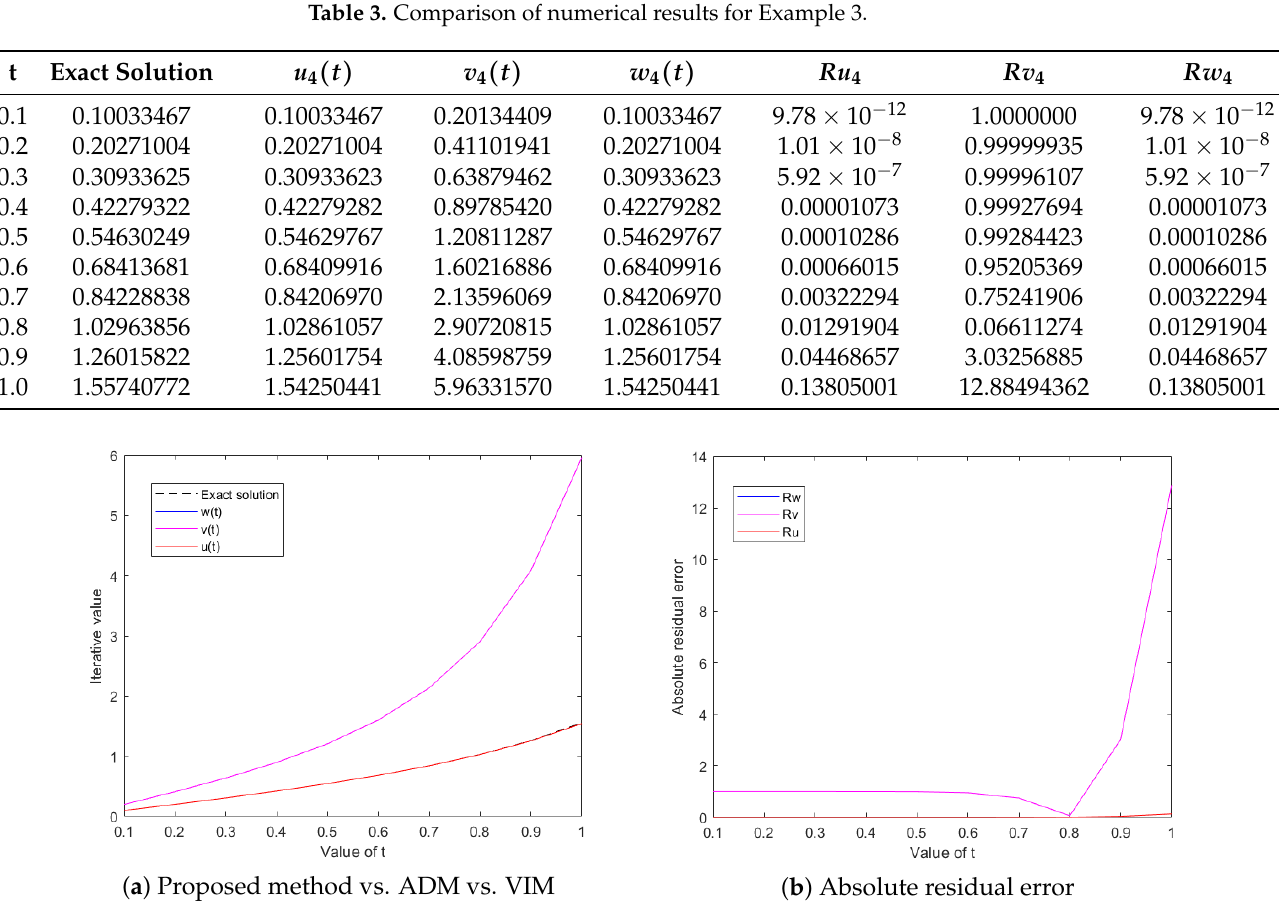
Figure 3. Comparison of numerical solutions and absolute residual errors obtained by the proposed method and existing methods for 0 ≤ t ≤ 1 of Example 3 with the available exact